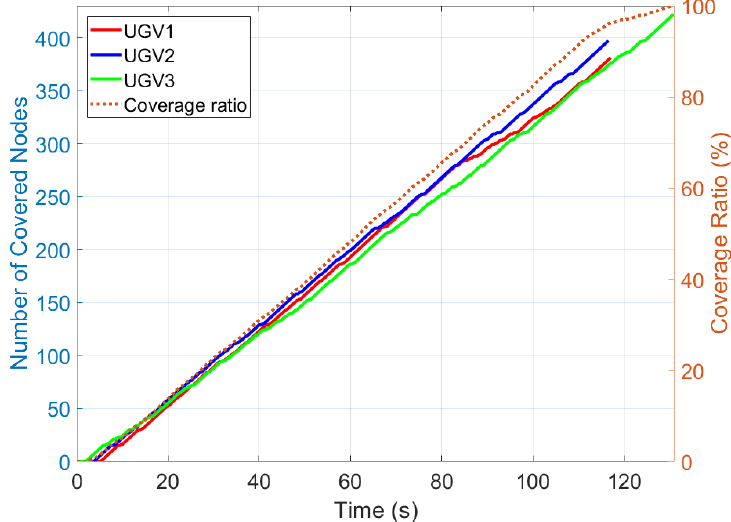
Figure 9. Results of the experiment. Coverage ratio and number of coverage nodes over